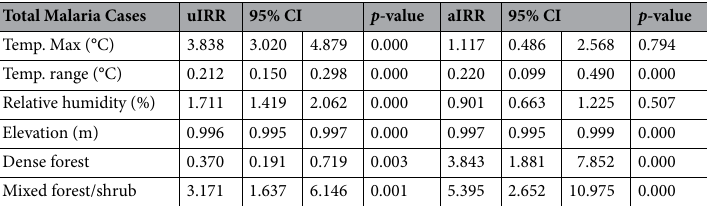
Table 2. Association between total malaria cases and the environmental variables. uIRR: unadjusted Incidence Rate Ratios, aIRR: adjusted Incidence Rate Ratios.